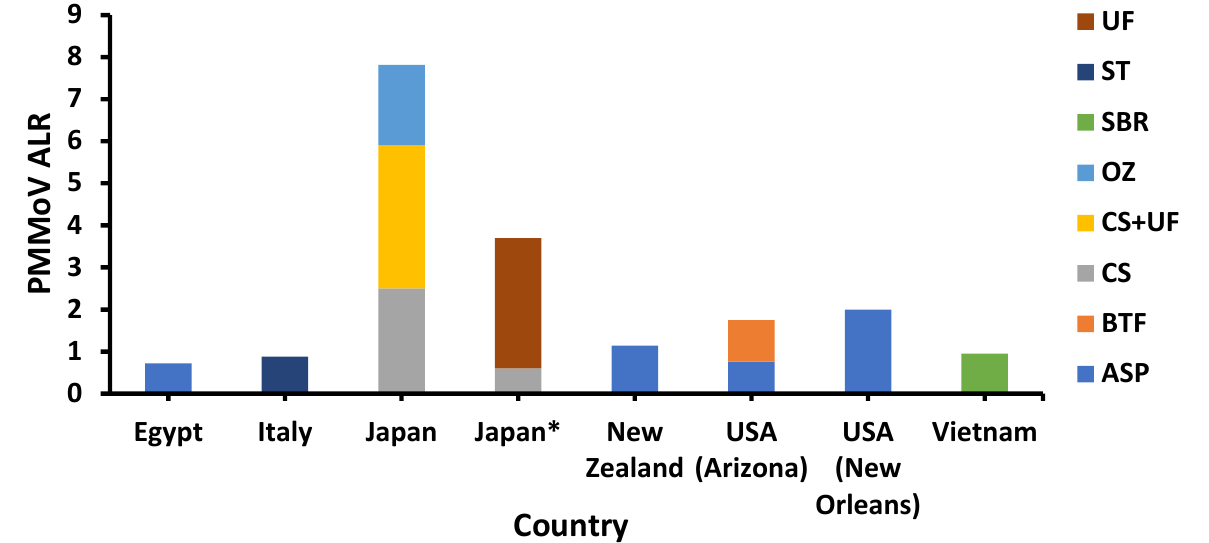
Figure 7. Average log reduction (ALR) rate of PMMoV by different wastewater treatment approaches in various countries [150,154,161,177,180,187,188,191]. UF: ultrafiltration, ST: secondary treatment, SBR: sequential batch reactor, OZ: ozone treatment, CS: coagulation sedimentation, BTF: biological trickling filter (Biotower), ASP: activated sludge process. *: refers to a different study conducted in Japan [177].